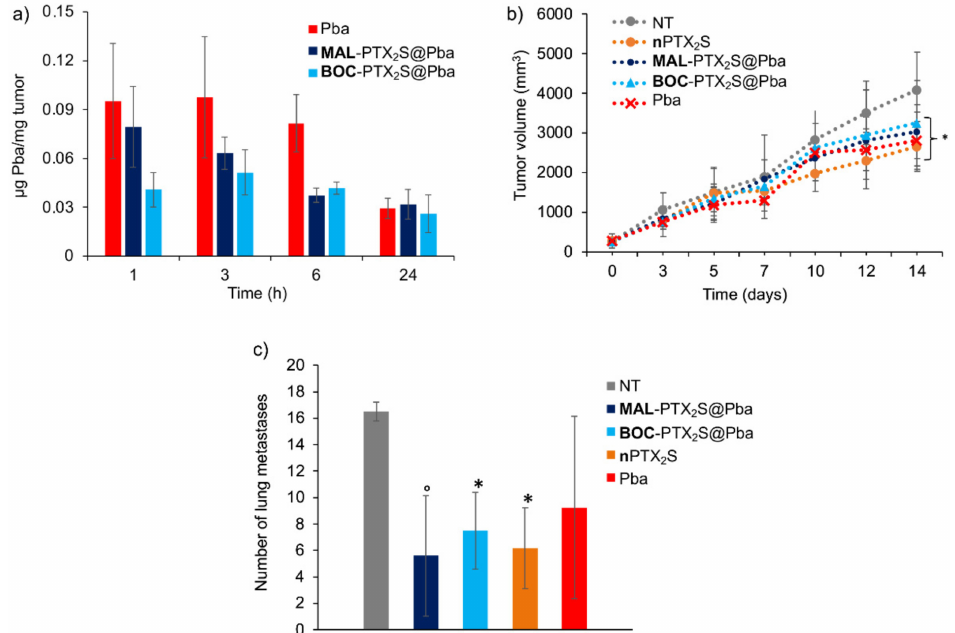
Figure 11. Effect of nanoparticles on 4T1 tumor-bearing mice. ( a ) Biodistribution of Pba in tumor after i.v. injection of Pba, MAL -PTX 2 S@Pba and BOC -PTX 2 S@Pba (containing 2.34 mg/Kg Pba); see Section 2.10.1 for experimental details. Each bar is the average of three measurements (three mice). ( b ) Antitumor efficacy of nanoparticles on primary tumor growth. Treated mice were injected on day 0 with a single i.v. treatment of 100 µ L (injectable water) MAL -PTX 2 S@Pba, BOC -PTX 2 S@Pba, n PTX 2 S and Pba (2.34 mg/Kg Pba and 8.16 mg/Kg PTX). Three hours after injection, the tumor mass was irradiated with a 660 ± 5 nm laser (193 J/cm 2 ). (* p < 0.05 vs. untreated group, ANOVA test). ( c ) Antitumor efficacy on the number of lung metastases. Lungs were harvested on the sacrifice day (standard error). Symbols indicate the significant difference from the control group ( ◦ p < 0.01 and * p < 0.05, respectively, ANOVA Dunnett multiple comparison